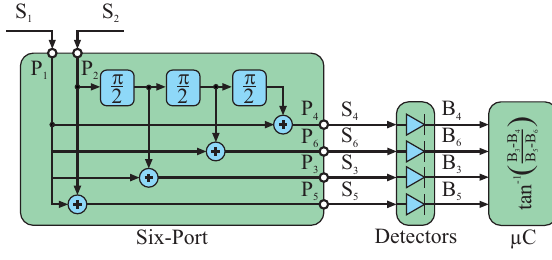
Figure 1. The two input signals S 1 and S 2 are superimposed inside the six-port structure under four different static phase shifts Φ S that are multiples of π